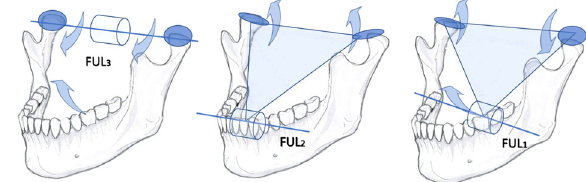
Fig. 1 The possible kinematics of mandible in a free, vertical jaw- closure. In the left panel, the condylar axis serves as a fulcrum (FUL 3 ) for a class 3 lever for the clockwise rotation of mandible (arrows). The anterior part of mandible moves upward. Minimal amount of reaction force is subjected to the temporomandibular joints, and the synovial spaces of the joints are presented as in fl ated circles. The middle panel depicts the instant of the fi rst tooth contact of an AF- bite. The unyielding ANT-contact stops the original movement. The point of contact instantaneously creates a novel fulcrum (FUL 2 ) for a class 2 lever, to causes an acute counterclockwise tilt of the body of mandible. The synovial fl uid spaces of both jaw joints are presented to be de fl ated and fl attened by the reaction force. The right panel illustrates an alternative course of the kinematics of mandible, where a BAT-contact occurs fi rst (the BF-bite). The fi rst contact in the left BAT-area instantaneously transforms into a fulcrum (FUL 1 ) for a class 1 lever. The reaction force tilts the tip of mandible upward, whereas distraction of the ipsilateral joint (in fl ated circle), con- comitant with compression of the contralateral joint (de fl ated circle), may be